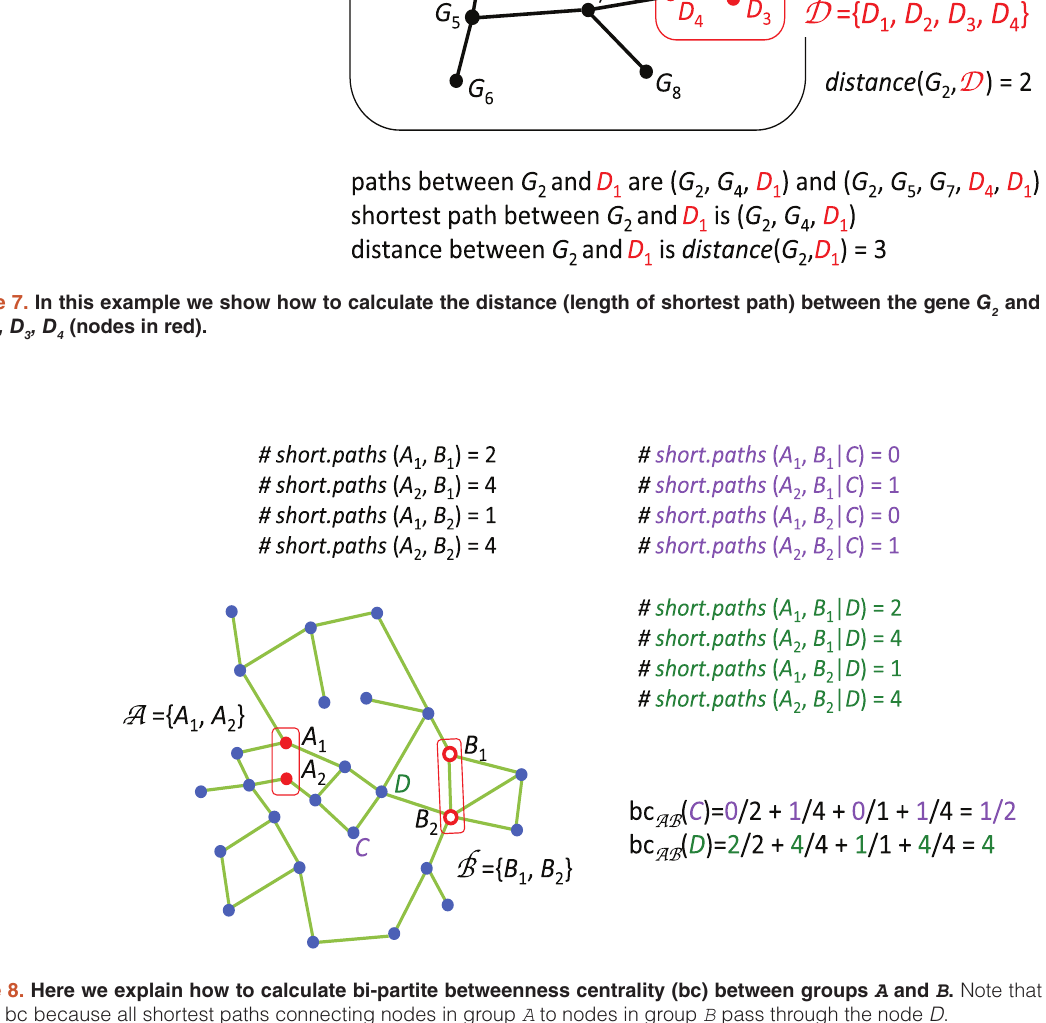
Figure 8. Here we explain how to calculate bi-partite betweenness centrality (bc) between groups A and B . Note that the node D has bigger bc because all shortest paths connecting nodes in group A to nodes in group B pass through the node D